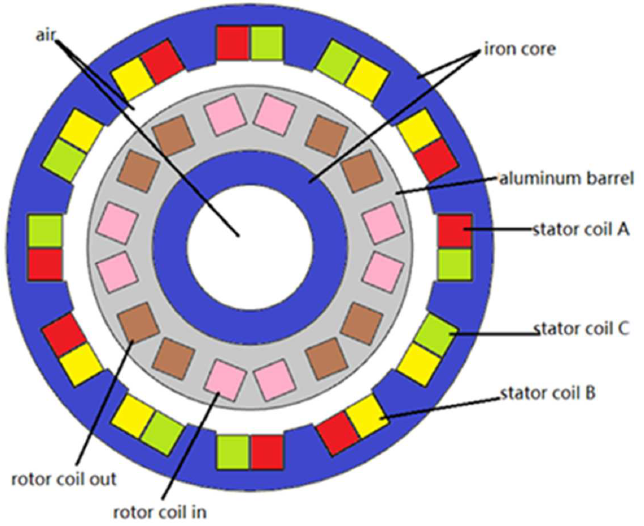
Table 1. HTS tape properties.